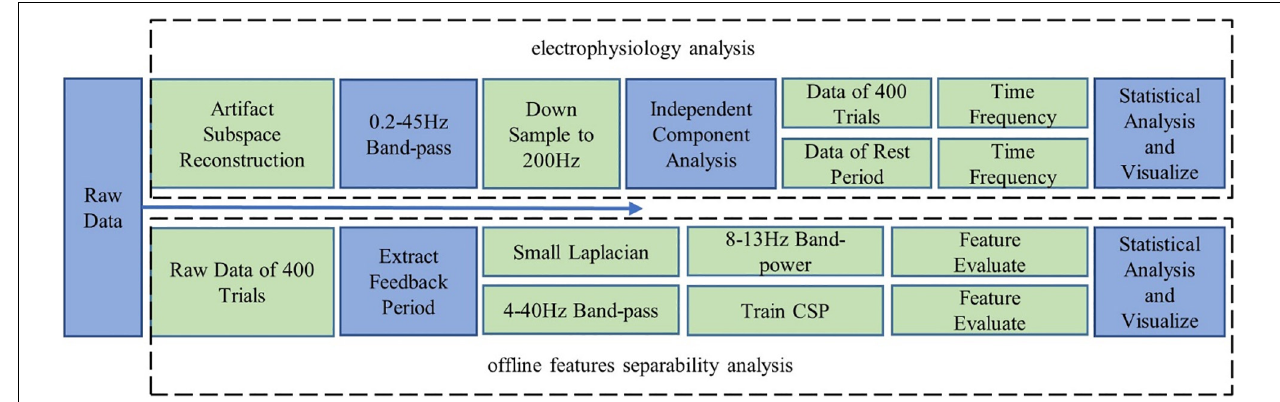
FIGURE 2 | Data analysis plan: electrophysiology analysis; offline features separability